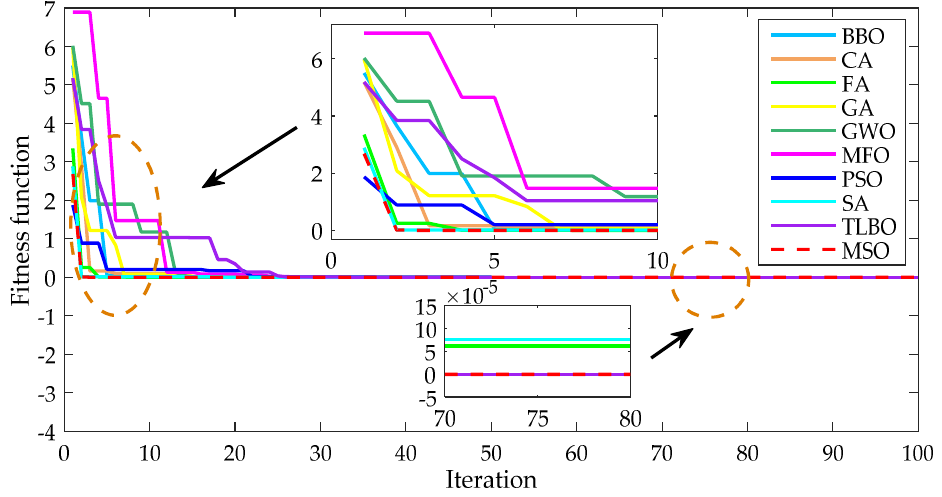
Figure 8. Comparison of convergence curves of ten algorithms in multi-peak test function.